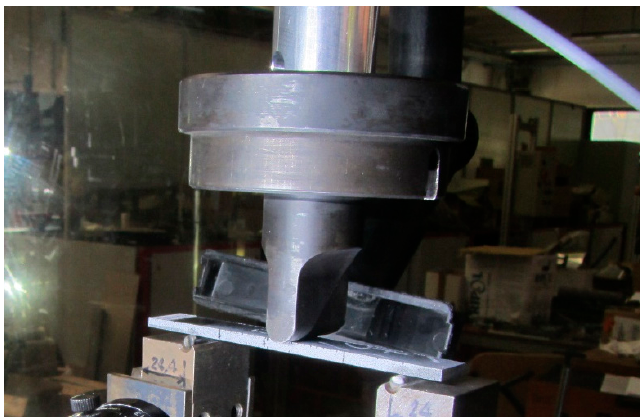
Figure 4. End ‐ notched flexure ( ENF) sample under Mode ‐ II test. Figure 4. End-notched flexure (ENF) sample under Mode-II